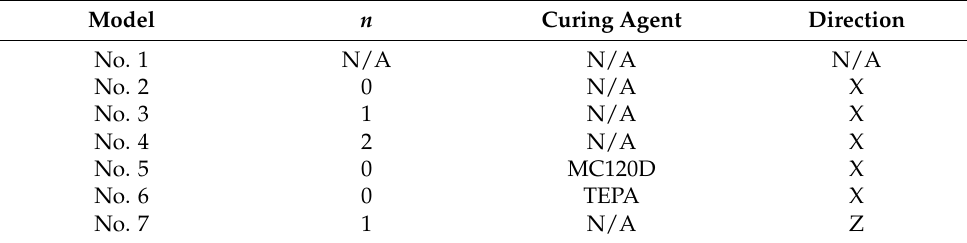
Table 1. Parameters of seven simulation models. Model